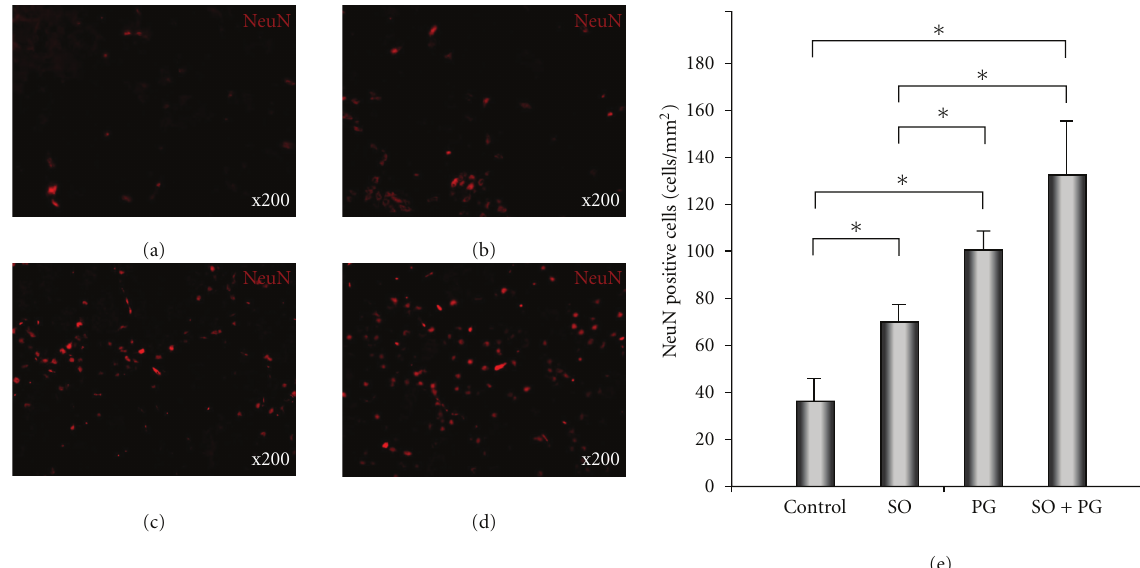
Figure 5: Quantitative analysis of NeuN-positive cell. These figures show the NeuN positive cells on peri-infarct area in Con group (a), SO group (b), PG group (c), and SO plus PG group (d) at 15 days after MCAO. The number of NeuN positive cells in this area showed significant di ff erence between control group and all treated groups. The number of these cells decreased very much in the control group. There were many NeuN-positive cells in SO + PG group compared to other groups. However, there was no di ff erence between PG and SO + PG group. ∗ P < .